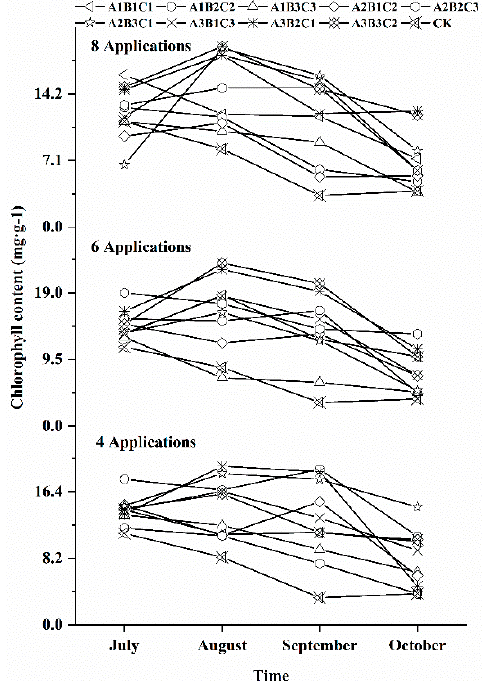
Figure 3. Dynamic changes in the seedling chlorophyll content under different fertilization ratios and frequencies.